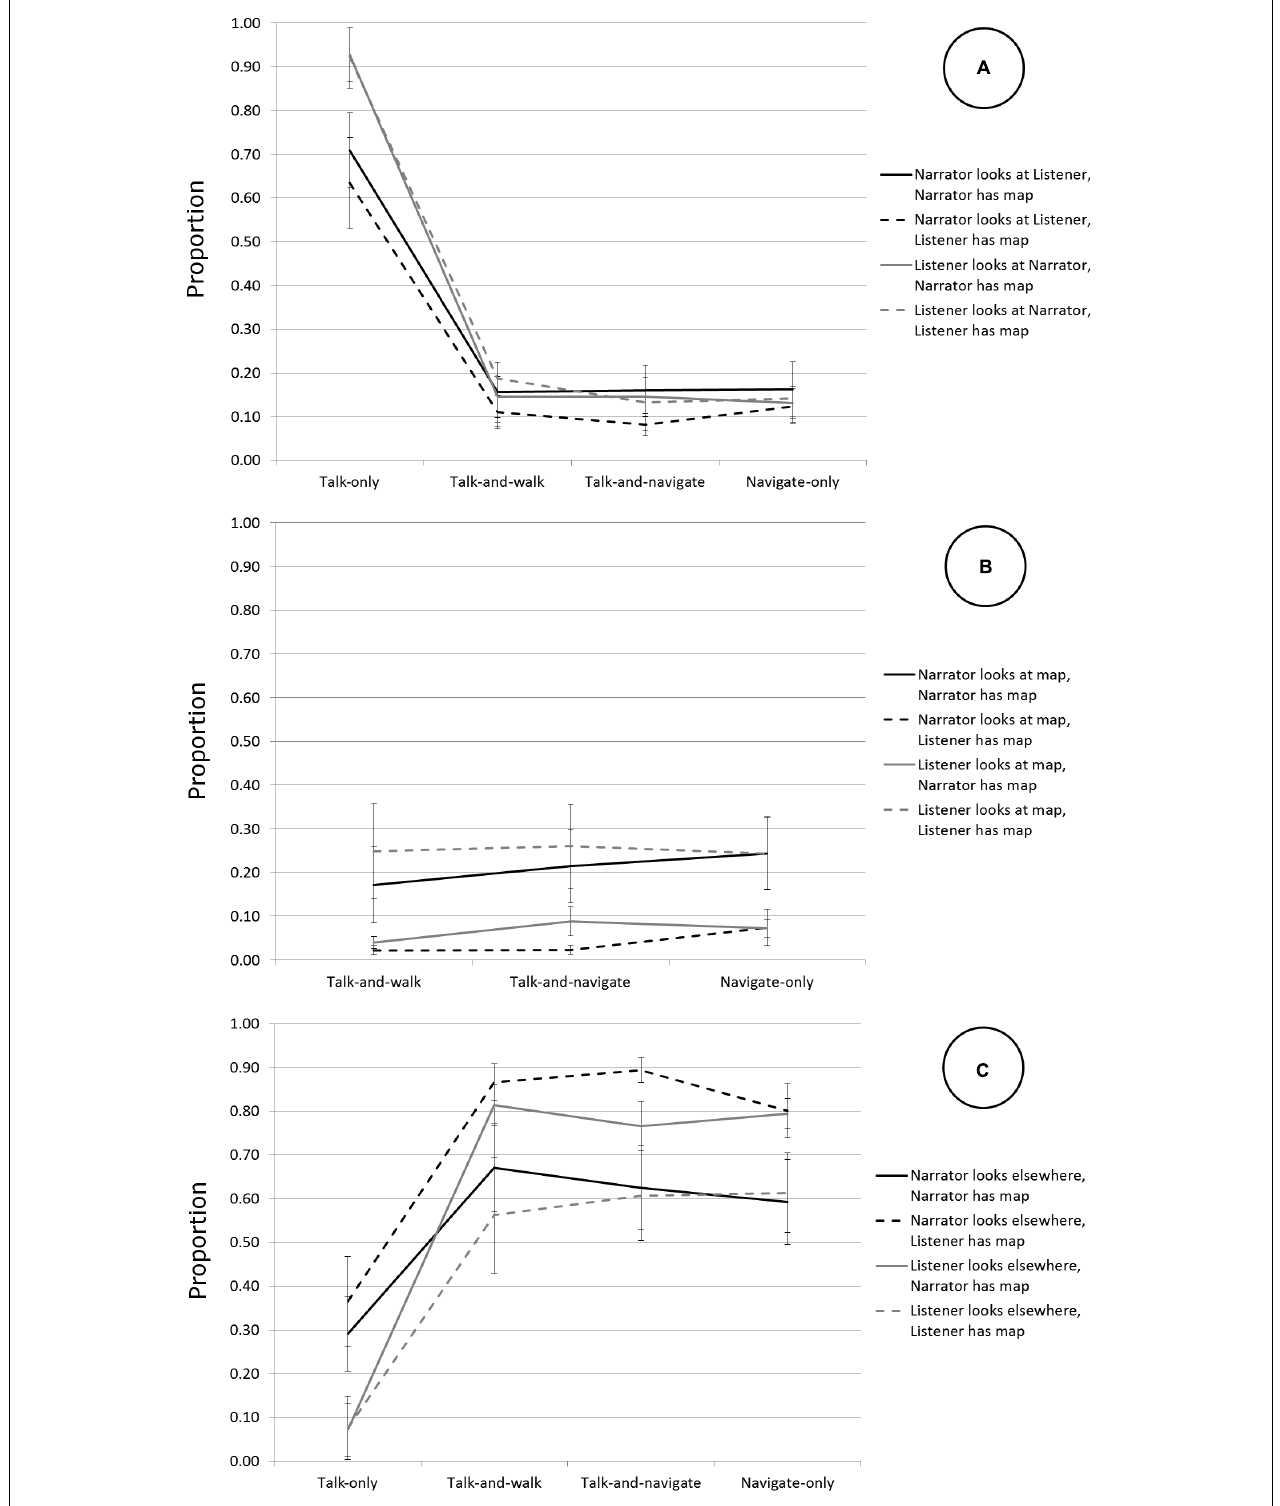
FIGURE 2 | Gaze allocation in stationary and mobile conversations. (A) Proportion of gaze at partner. (B) Proportion of gaze at map. (C) Proportion of gaze elsewhere. Error bars represent the standard error of the mean.